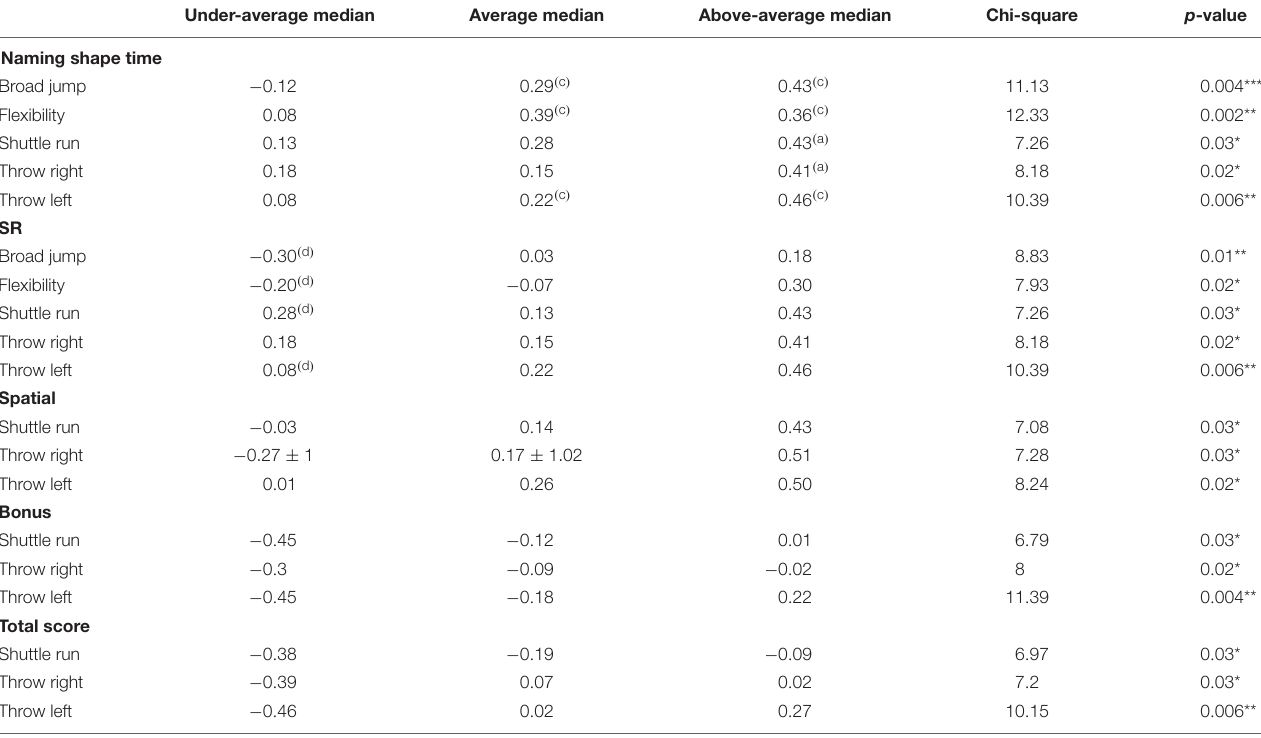
TABLE 5 | Differences in physical fitness performance depending on Naming shape time. Under-average median Average median Above-average median